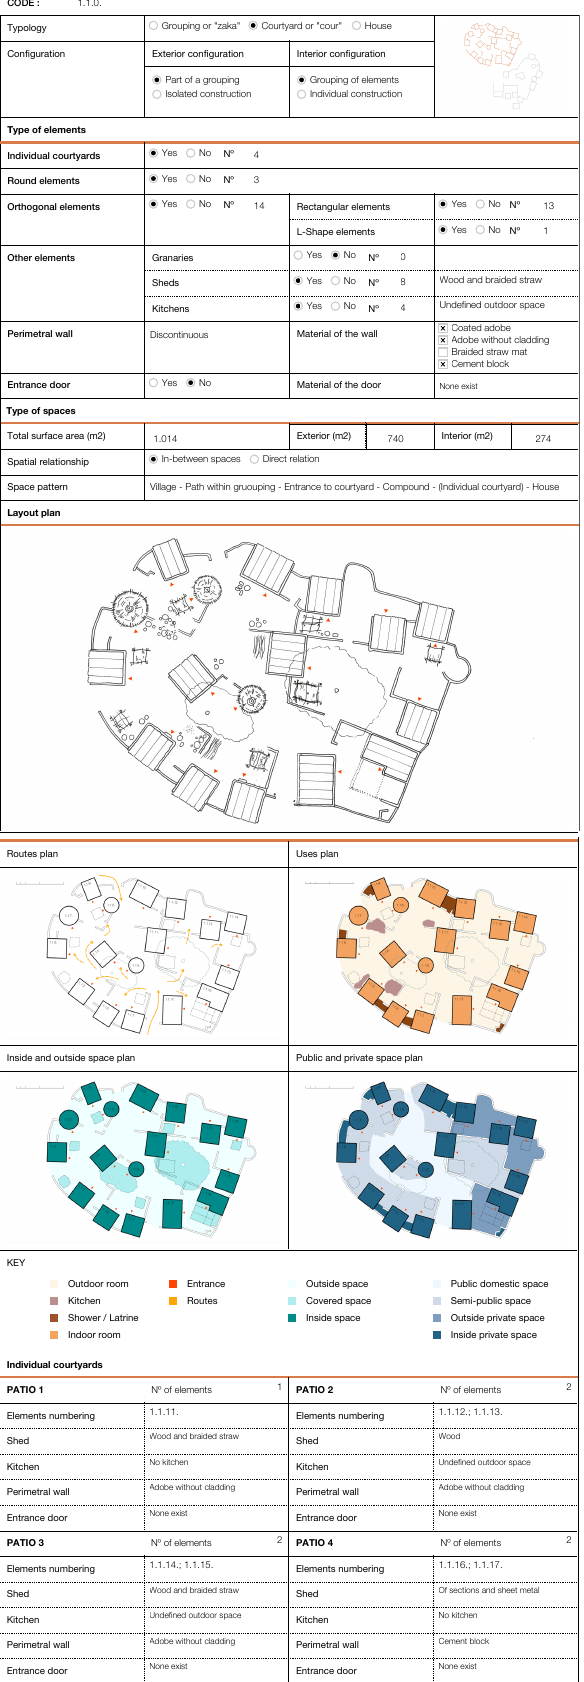
Figure 4. Fiche B: Analysis of spaces and